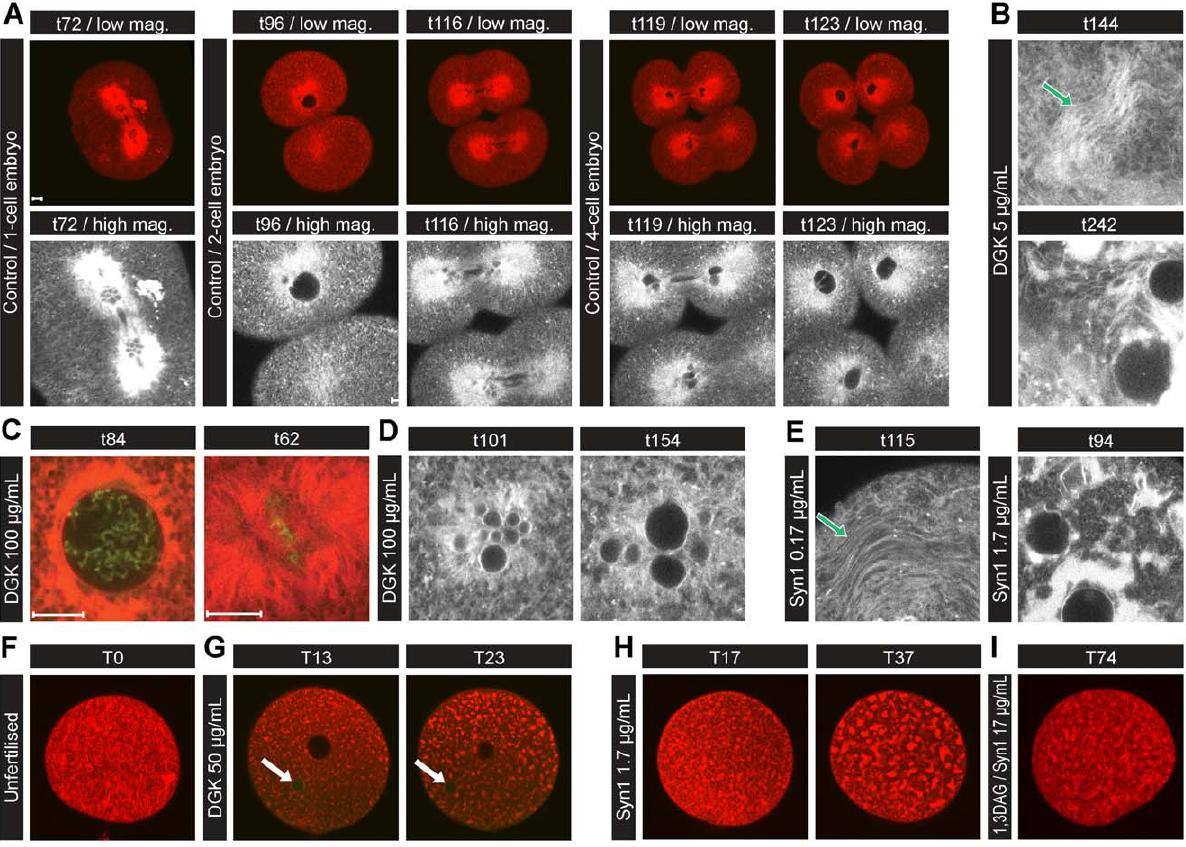
Figure 6. Effects of DGK and Synaptojanin1 microinjection on sea urchin embryos and eggs. (A) Fertilised eggs. The ER was labelled by microinjection of DiIC 18 into sea urchin eggs between 10–25 min post fertilisation. Karyomeres in the first cell cycle resolve into individual nuclei between 72 and 96 min post-fertilisation and in the second cycle (4-cell stage) between 116 and 123 min. (B) At 5 m g/ml pipette concentration of DGK, curved stacked sheets of ER formed by 144 min that coalesced into more concentrated ‘‘aggregates’’. (C) At 100 m g/ml of DGK, either chromosomes condensed but the NE did not break down or an apparently normal metaphase occurred but karyomere fusion (D) was greatly retarded compared to the first cycle controls. (E) Synaptojanin 1 (Syn1) induced a similar phenotype of karyomere resolution delay to DGK as well as formation of curved stacked sheets of ER that coalesced into ‘‘aggregates’’ of sheets (0.17 m g/ml and 1.7 m g/ml shown). Unfertilised haploid eggs (F) were injected with either 50 m g/ml DGK (G) or 1.7 m g/ml Syn1 (H) which rapidly converted the ER in a progressive coarsening of the pattern similar to fertilised eggs already detectable by 13 or 17 minutes post-injection (Movie S9). The upper dark circle in (G) images is the injected oil droplet; lower green circle (arrow) is the zygote nucleus with NE that does not undergo breakdown. (I) Unfertilised eggs were incubated with SUVs containing PtdCho and 1,3 DAG (80:20 mole%) prior to Syn 1 injection (17 m g/ml) at T0. Their appearance did not change for more than 74 min (Movie S10). All embryos were injected with enzymes , 40 min post-fertilisation. YOYO H -1 iodide was included to label nucleic acid green and monitor injection. Scale bars: 10 m m.